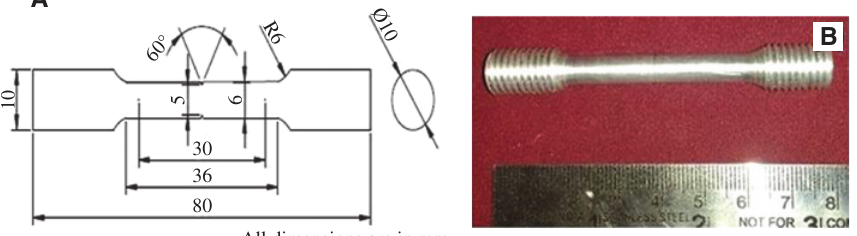
Figure 2: Stress corrosion crack test specimen details. (A) Specimen design. (B) Photograph of the specimen.